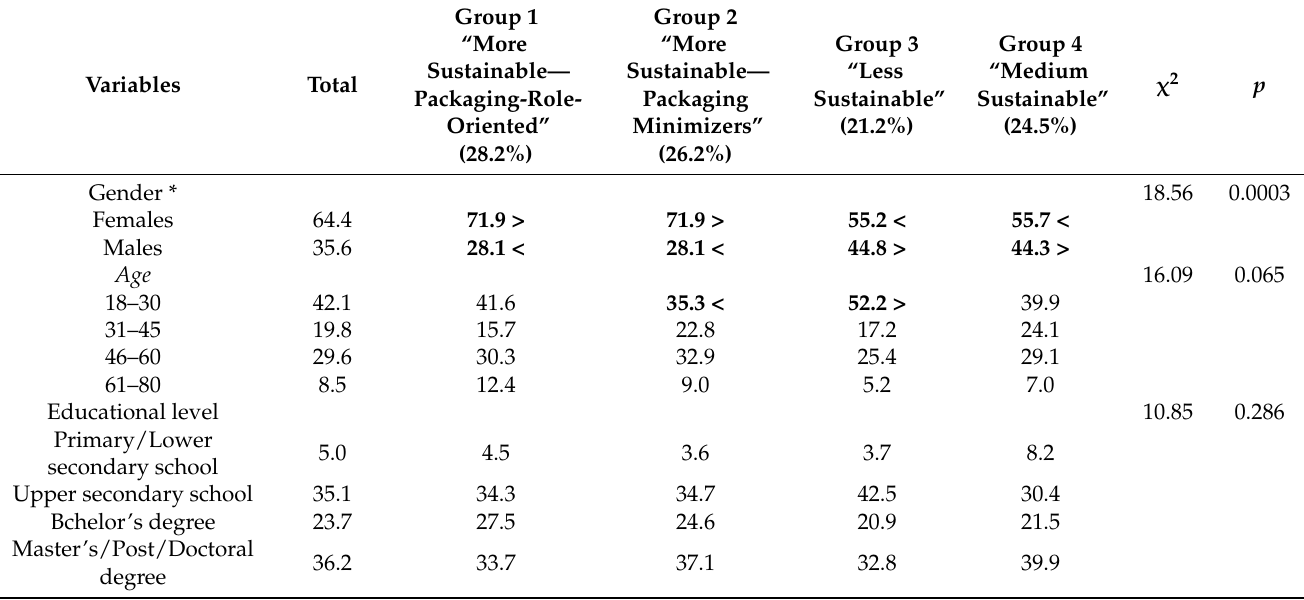
Table 5. Socio-demographic characteristics of the four identified groups of participants ( n =